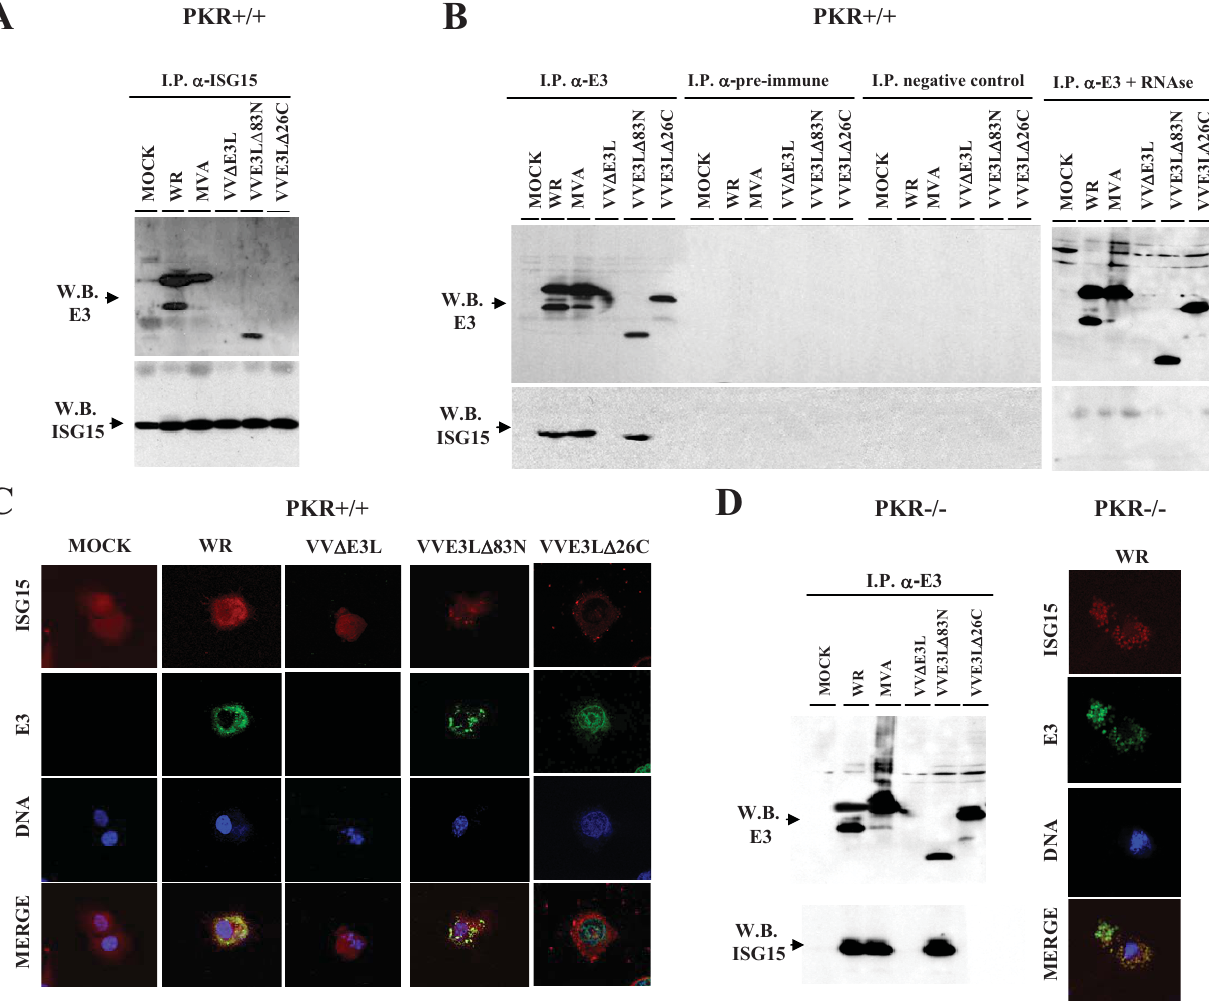
Figure 5. E3 interacts with ISG15 protein. A . PKR + / + MEFs were treated with mouse IFN- a (100 units/ml) during 10 hrs and then infected with 3 PFU/cell of WR, or MVA or VV D E3L or VVE3L D 83N or VVE3L D 26C for 16 hours. Cell extracts were collected at 16 hpi and immunoprecipitated using anti-ISG15 serum, thoroughly washed and immunocomplexes analysed by SDS-PAGE and subjected to immunoblotting with antiserum to E3 or ISG15. B . PKR + / + cells were treated as above and cell extracts were collected at 16 hpi and immunoprecipitated using anti-E3 (with or without RNase treatment (10 m g for 15 min at room temperature); or without antibody; or using a pre-immune serum, thoroughly washed and immunocomplexes analysed by SDS-PAGE and subjected to immunoblotting with antiserum to E3 or ISG15. C . PKR + / + MEFs treated as in A were fixed at 16 h.p.i. and processed for immunofluorescence analysis by confocal microscopy using antibodies directed against ISG15 (red), E3 (green), and TOPRO for staining nuclei (blue). Merged images are presented in the lower panels. Cells were visualized by confocal immunofluorescence microscopy. D . Immunoprecipitation and immunoflurescence of PKR 2 / 2 MEFs was performed as in A or in C .